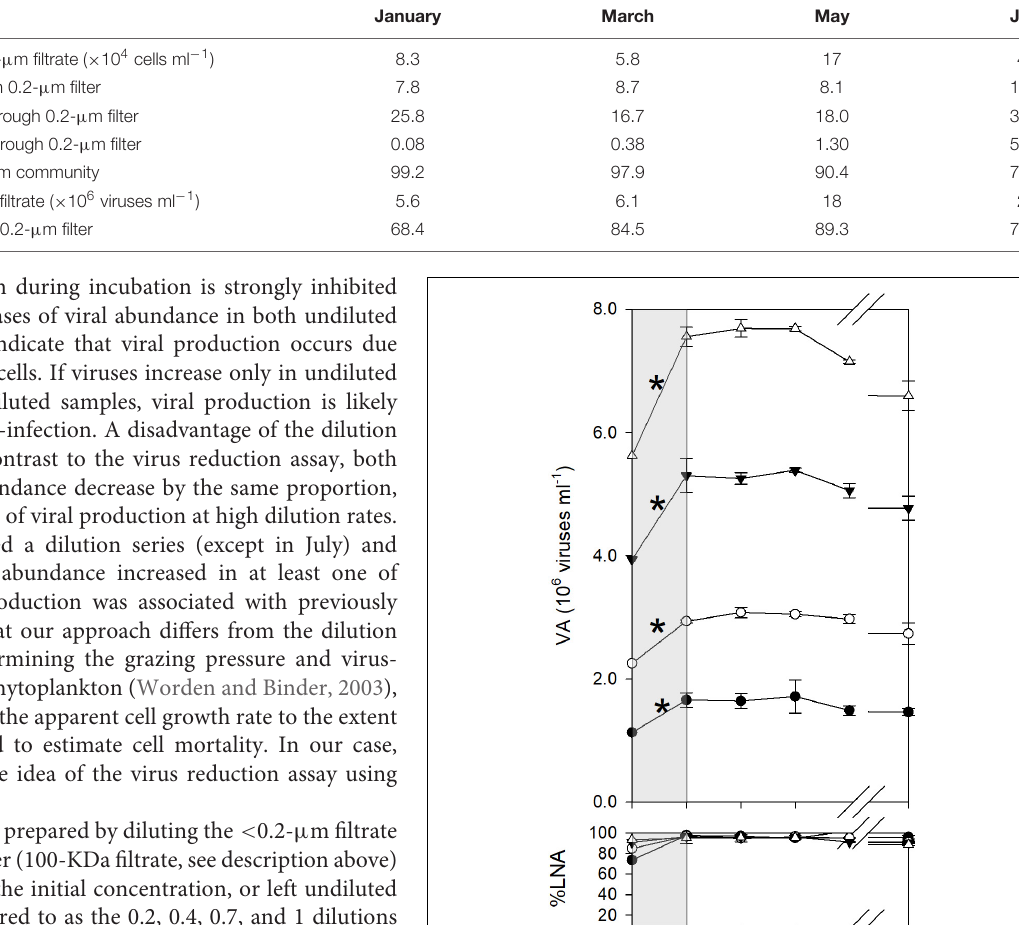
TABLE 1 | Abundances and fractions of bacteria and viruses that passed through 0.2- µ m filters.